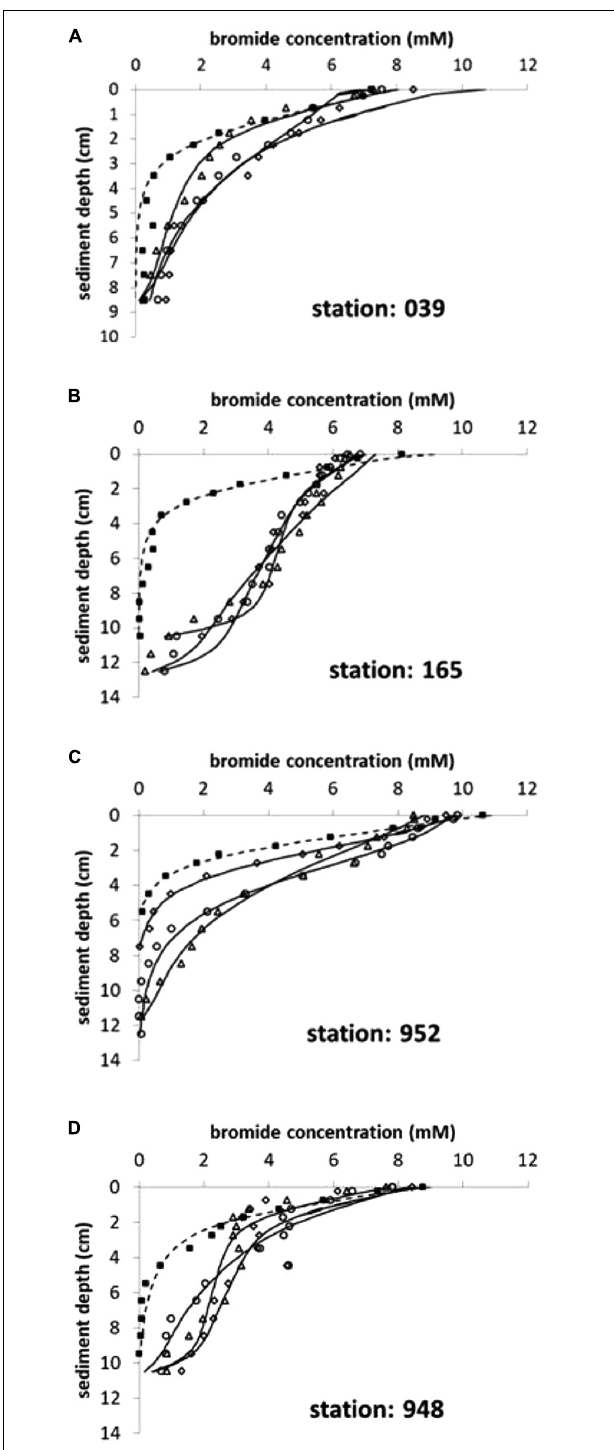
FIGURE 2 | (A–D) Bromide concentration profiles in sediment cores after 3 days of incubation. Four stations in the Pomeranian Bay are shown with one control (squares; dashed line) and three replicate cores containing active fauna (core 1: triangles, core 2: circles, core 3: diamonds; solid lines). Lines depict the modeled tracer distribution with depth according to equation (2) and (3) using α 0 and α 1 values given in Supplementary Table 1